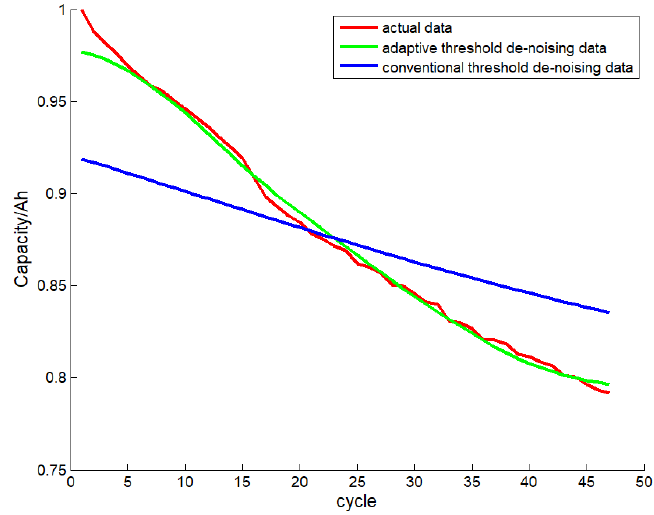
Figure 4. The de-noised results with these 2 different threshold values.